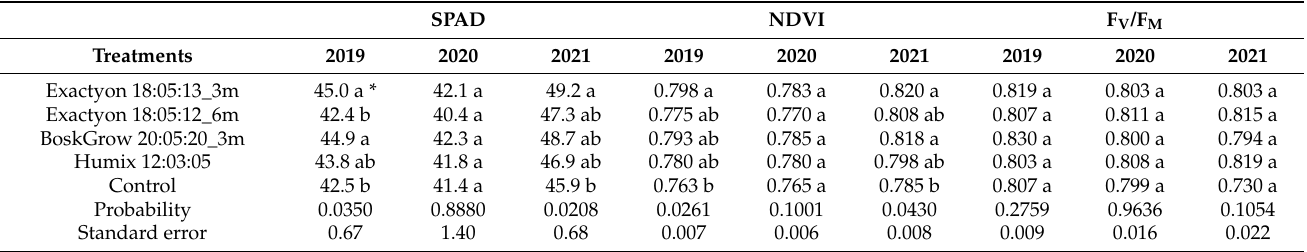
Table 3. SPAD (soil plant analysis development) values, NDVI (normalized difference vegetation index) and F V /F M (ratio of variable fluorescence/maximum fluorescence) in the summers of 2019, 2020 and 2021 as a function of the fertilizer treatments. SPAD NDVI F V /F